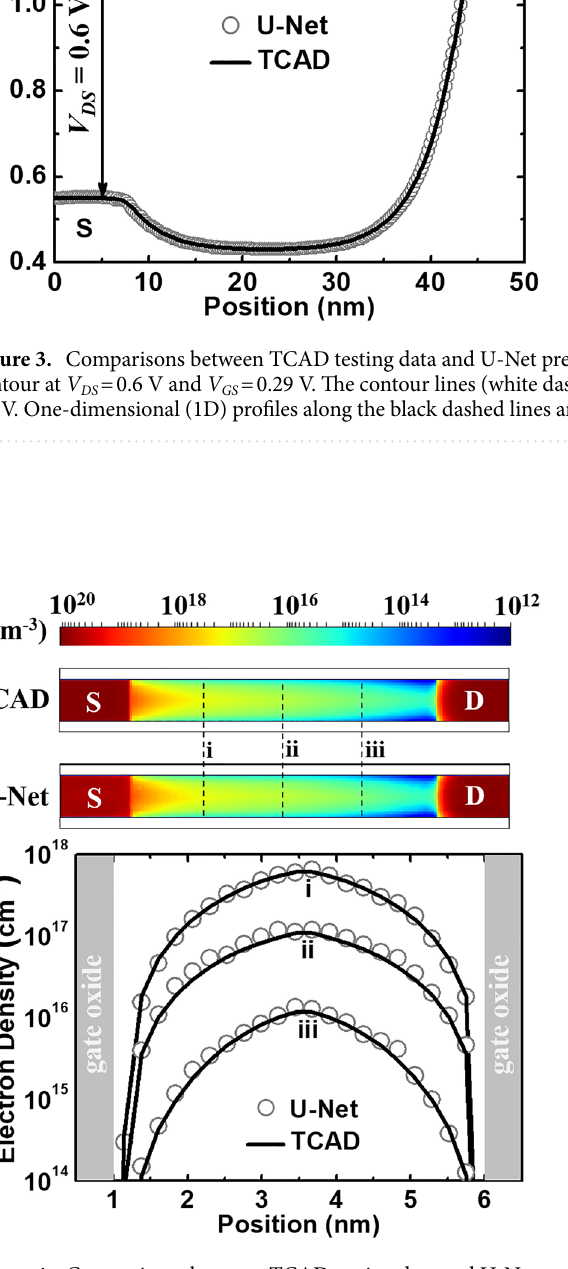
Figure 4. Comparisons between TCAD testing data and U-Net predicted results of electron density distribution at V DS = 0.6 V and V GS = 0.29 V. The white boxes represent oxide regions because there are no charges. 1D profiles along the black dashed lines are shown at the